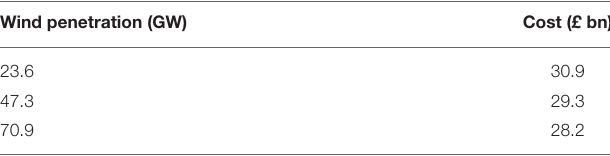
TABLE 4 | Total operational costs in the Ref